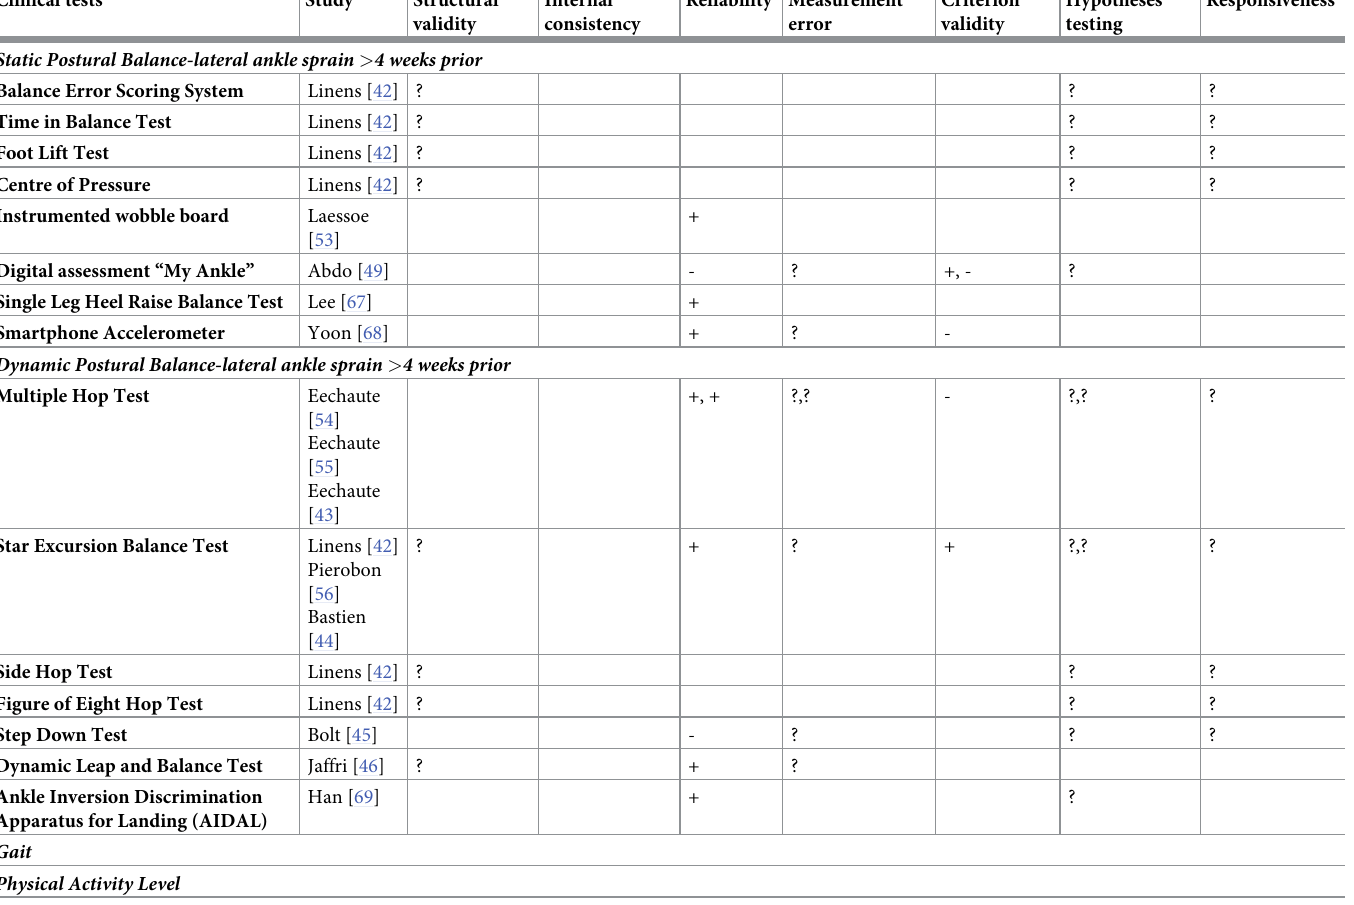
table adapted from COSMIN recommendations, Diagnostic accuracy studies are not mentioned as grading of measurement properties was not possible with these study